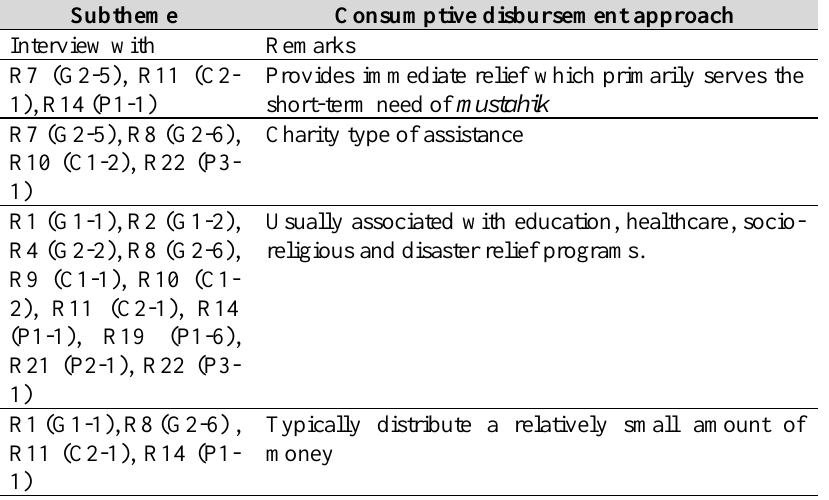
Table 3 Focused Coding 1 for the Distribution